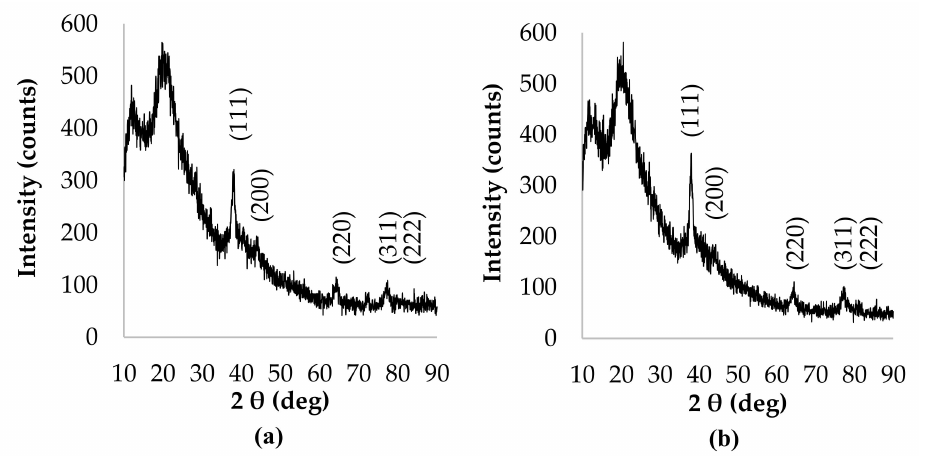
Figure 4. XRD diffraction patterns of AgNPs prepared with 5 mL of extract ( a ) and 5 mL of infusion ( b ) of C. incanus